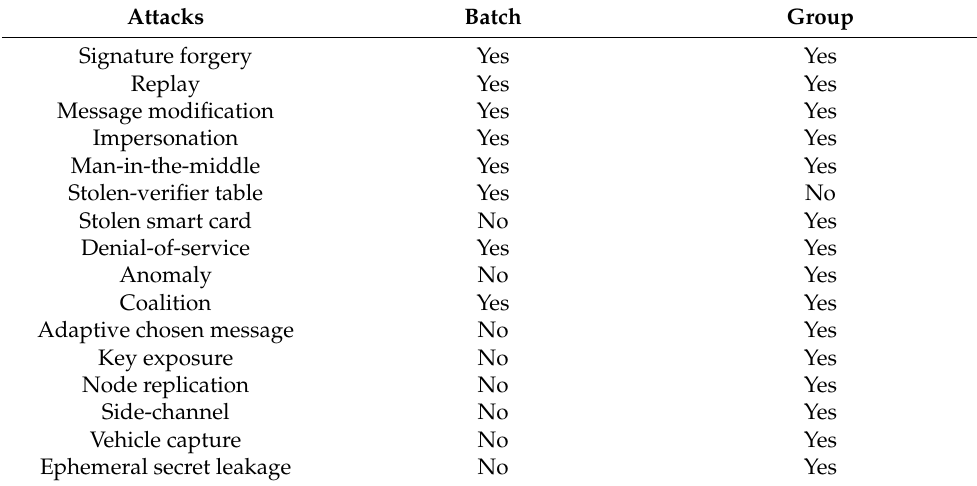
Table 14. Comparison based on attacks mitigated by batch vs group verification schemes.